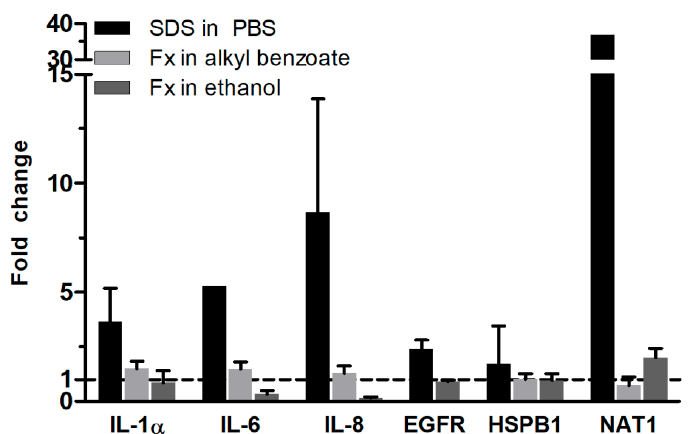
Figure 4. Fucoxanthin effects on the gene expression of reconstructed human skin. Fold change in gene expression was calculated in relation to the gene expression in reconstructed human skin exposed to the respective solvent (dashed line), SDS to PBS and Fx to alkyl benzoate or to ethanol. SDS—sodium dodecyl sulfate; PBS—phosphate-buffered saline; Fx—fucoxanthin; IL—interleukin; EGFR—epidermal growth factor receptor; HSPB1—small heat and shock protein beta 1; NAT1—N- acetyltransferase 1. Mean + SD, n = 3.